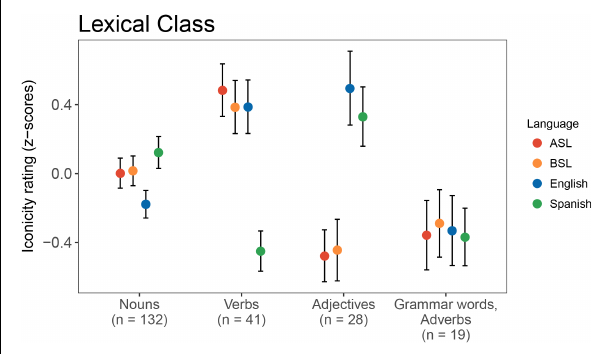
FIGURE 2 | Means and standard errors of normalized iconicity ratings for each language by English lexical class. The values were calculated from the 220 meanings for which we had iconicity ratings in all four languages. n indicates the number of shared words and signs for each lexical